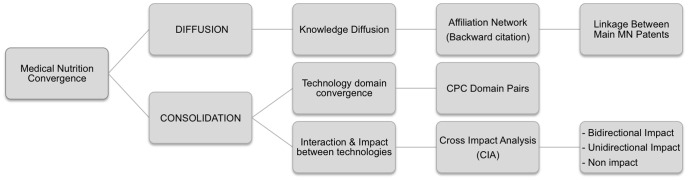
Research framework.